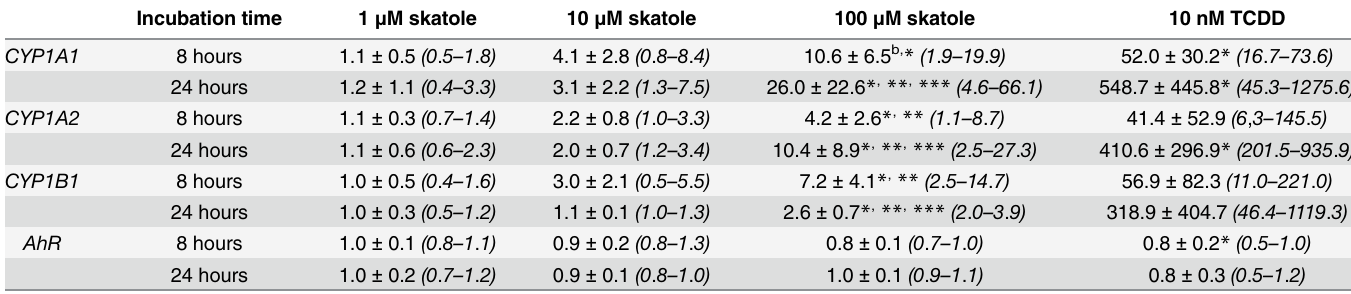
Table 3. CYP1A1 , CYP1A2 , CYP1B 1 and AhR mRNA expression in PHHs (n = 5) incubated with 1, 10, 100 μ M skatole or 10 nM TCDD for 8 or 24 hours. Incubation